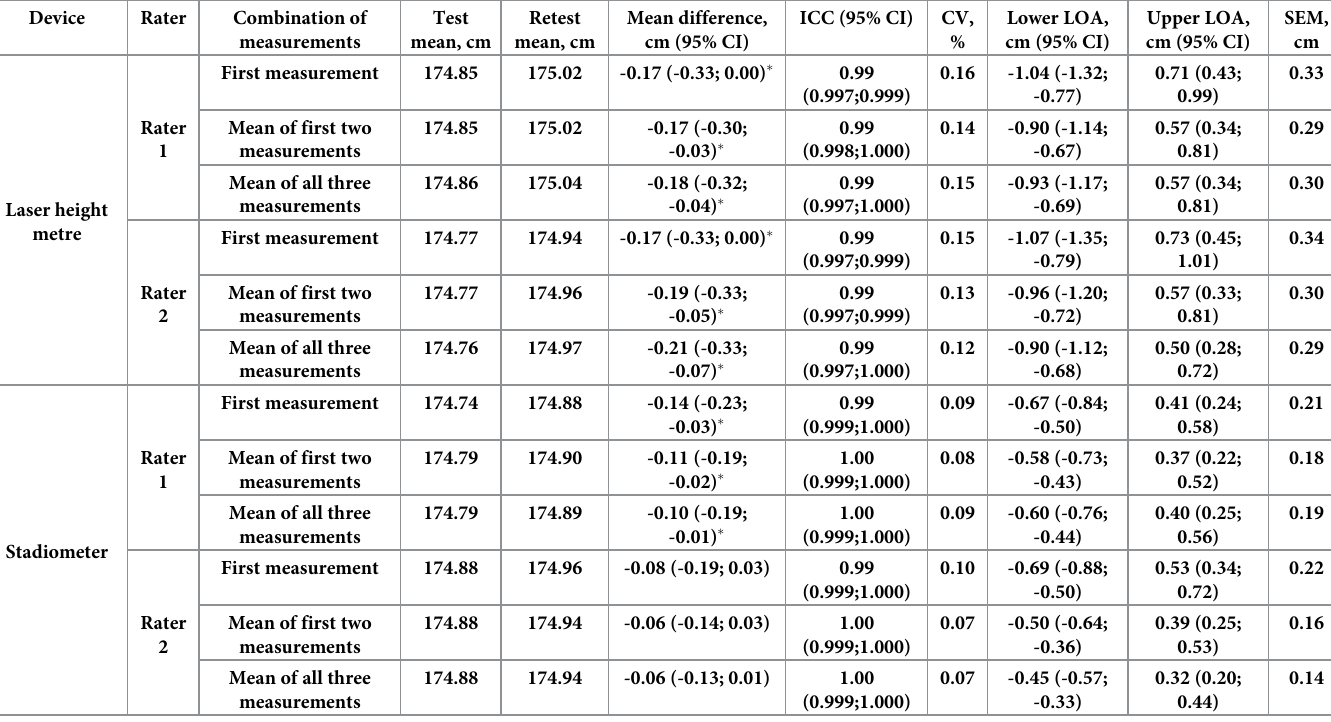
Table 1. Intrarater reliability for height measurements on each rater with the laser height metre and stadiometer (n = 32).